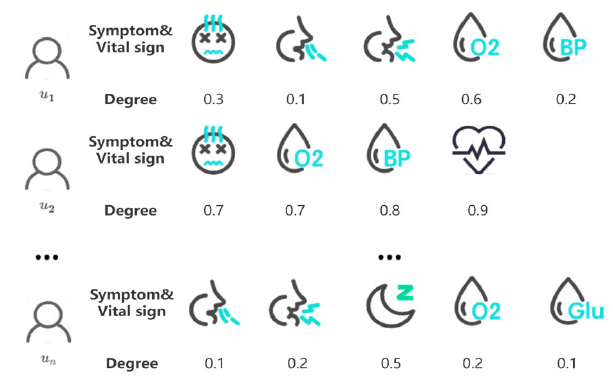
Figure 1. Symptoms and corresponding degree.